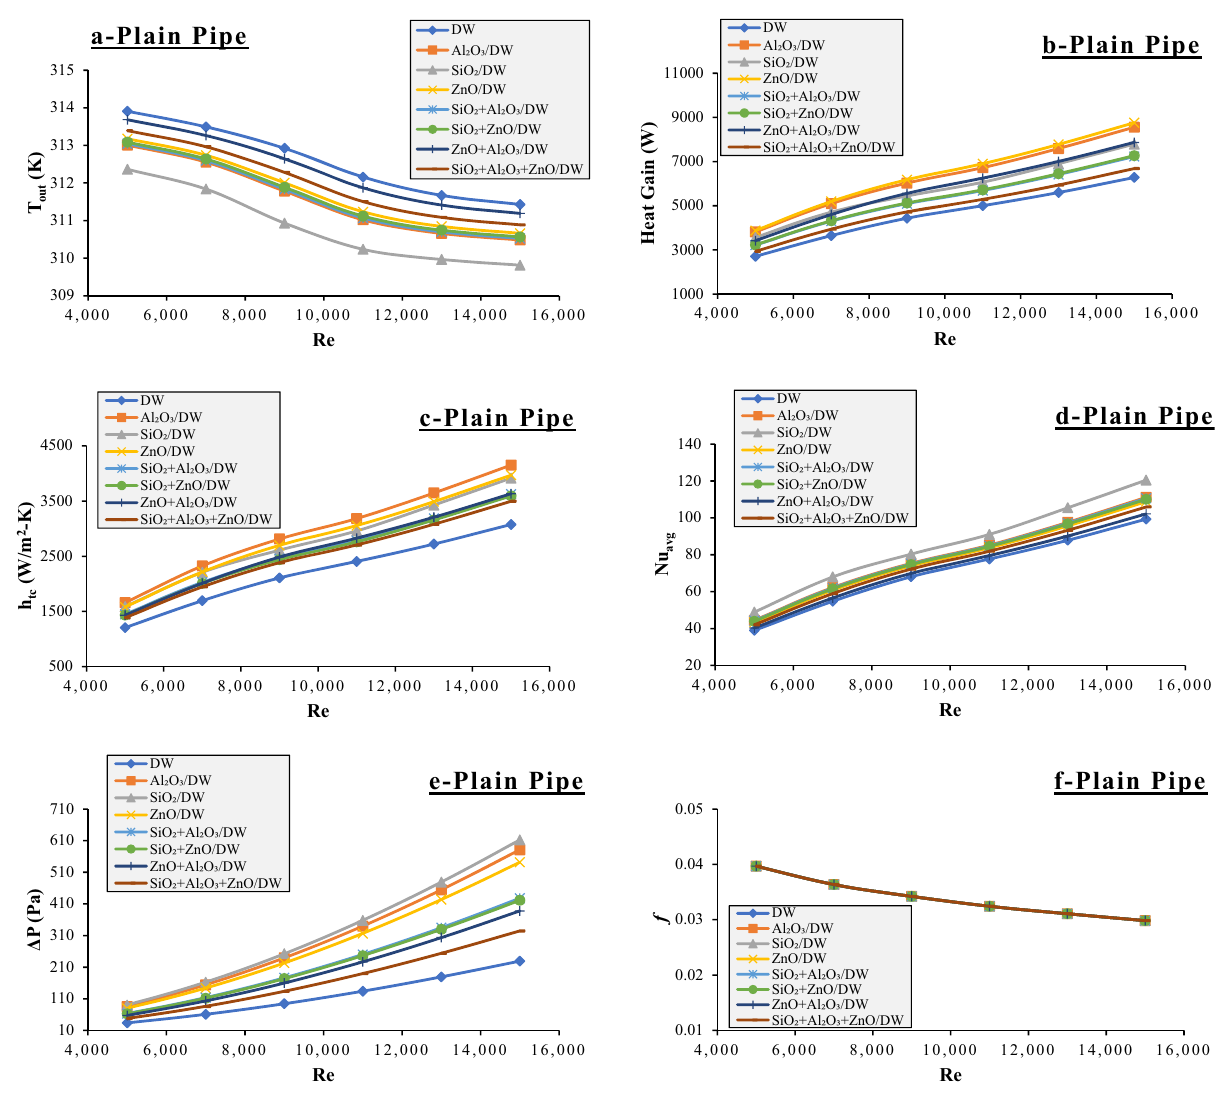
Figure 4: Thermohydraulic parameters of plain pipe using DW, single, hybrid, and ternary nano fl uids: ( a ) outlet temperature, ( b ) heat gain, ( c ) heat transfer coe ffi cient, ( d ) average Nusselt number, ( e ) pressure loss, and ( f ) friction